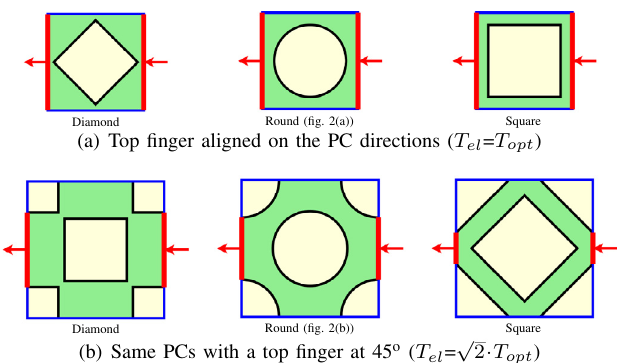
Fig. 3. On scale elementary electrical patterns for a square